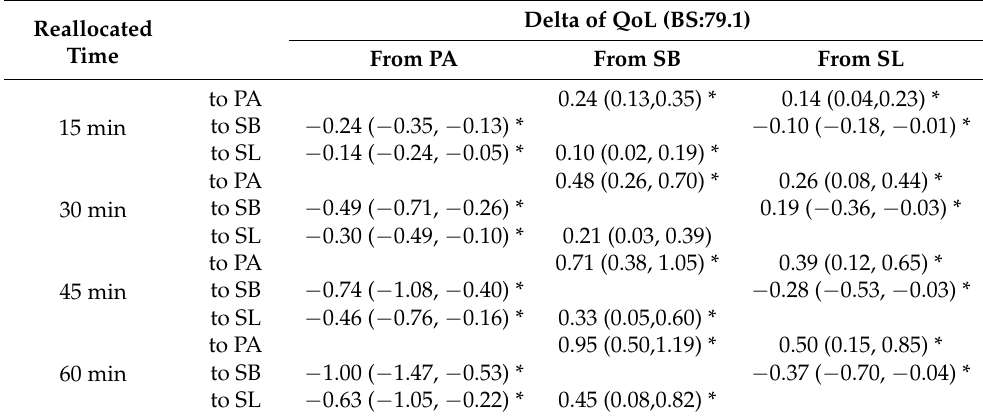
Table 4. Changes in QoL are predicted when reallocating time in PA, SB, and SL from the adjusted model in